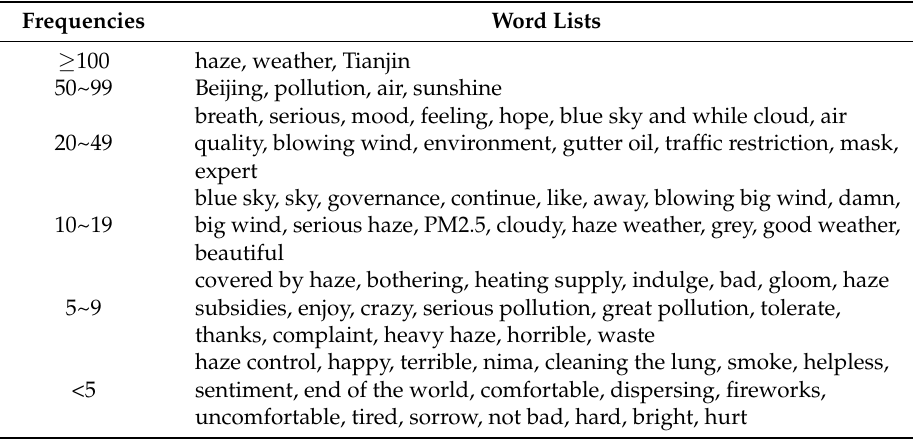
Table 3. The high-frequency words extracted by the NLPIR.